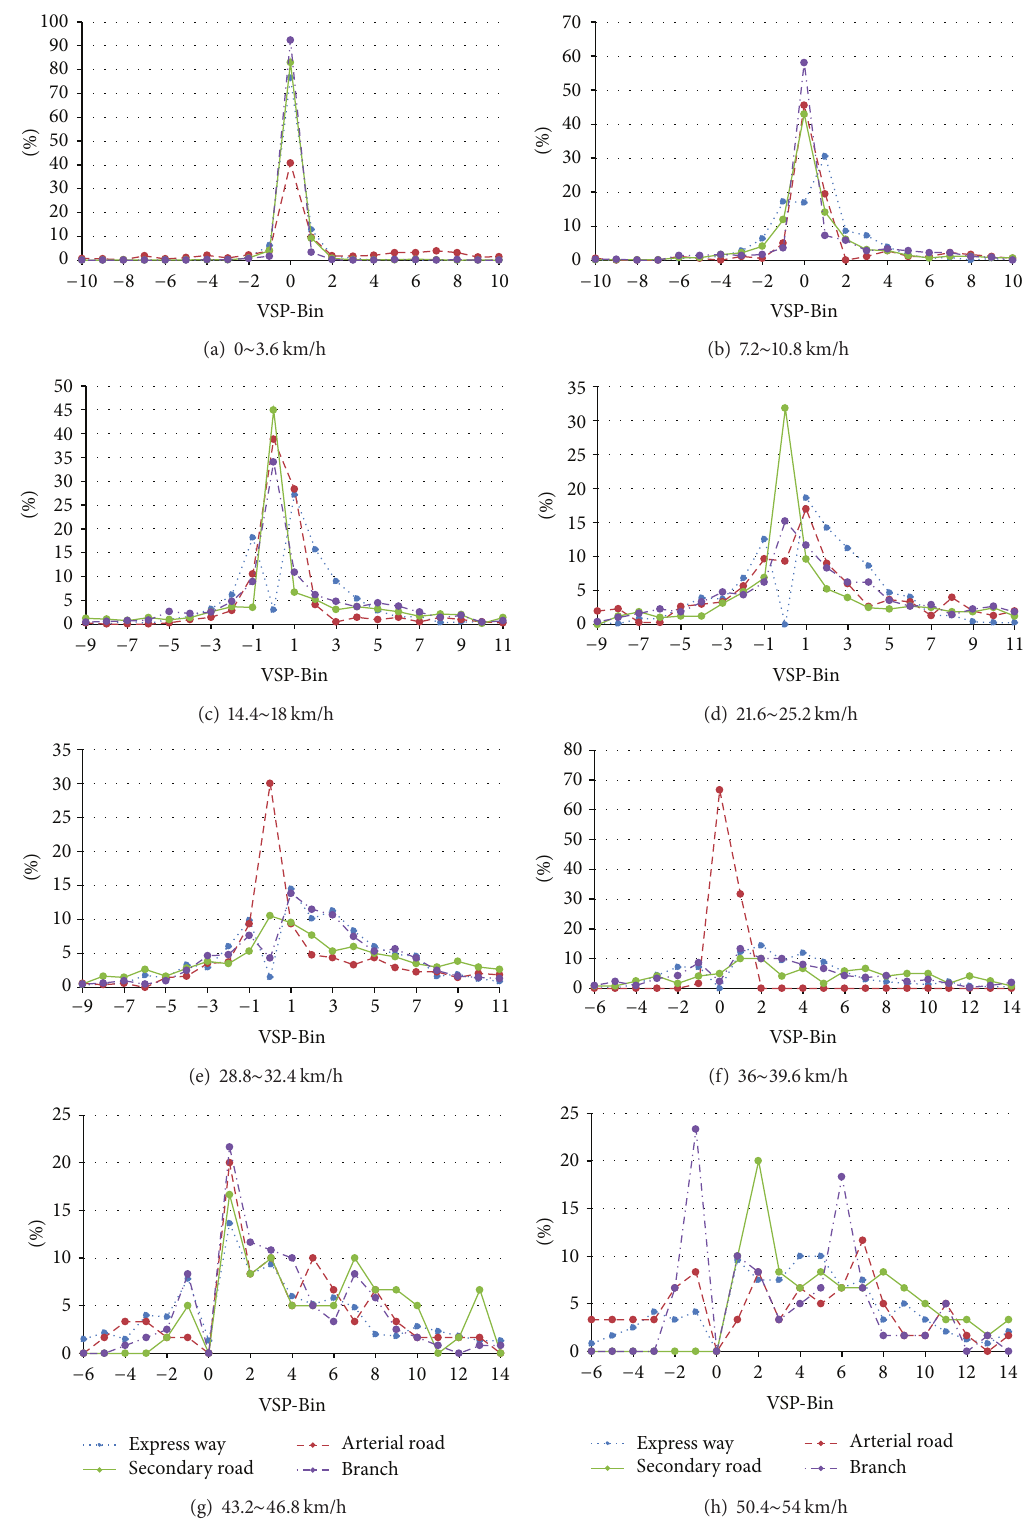
Figure 5: VSP-Bin distributions for different road